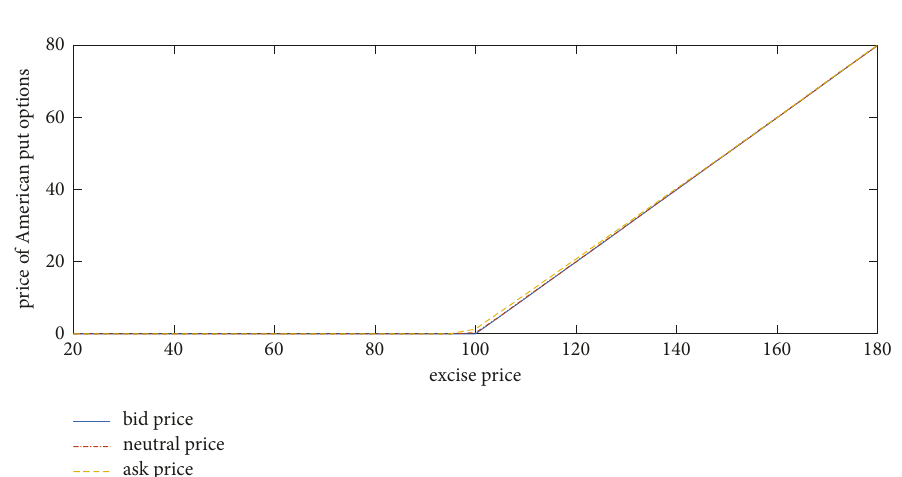
Figure 2: Prices of American put options with different excise